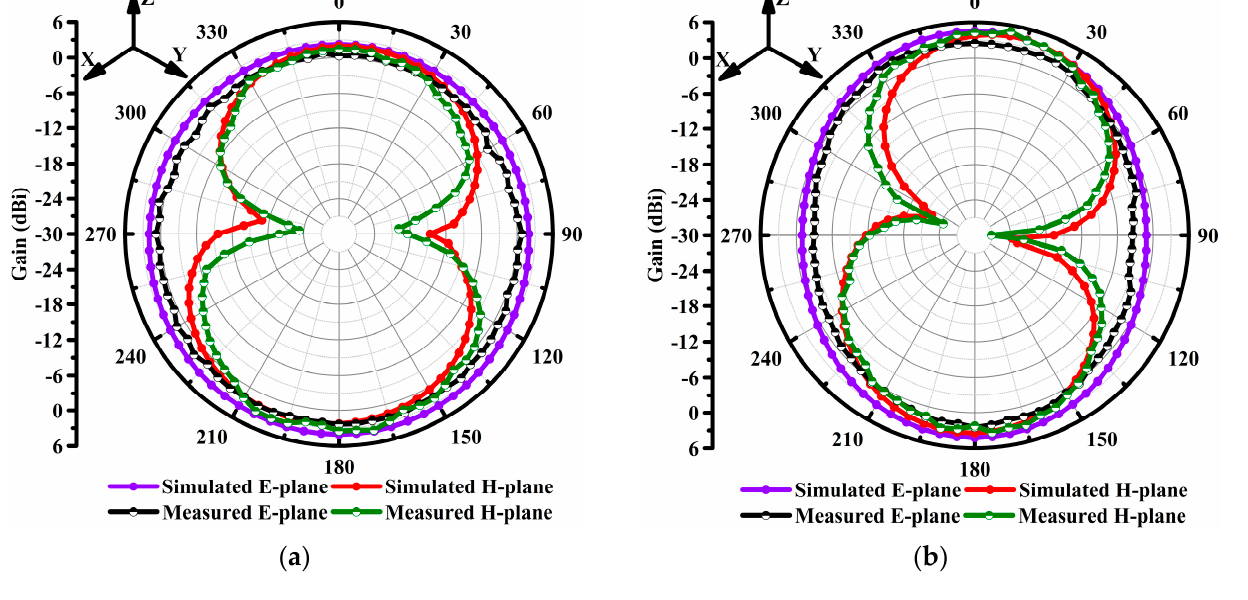
Figure 10. Radiation pattern performance ( Φ = 0°) and ( Φ = 90°) at different resonant frequencies: ( a ) at 4.52 GHz and ( b ) at 7.64 GHz.